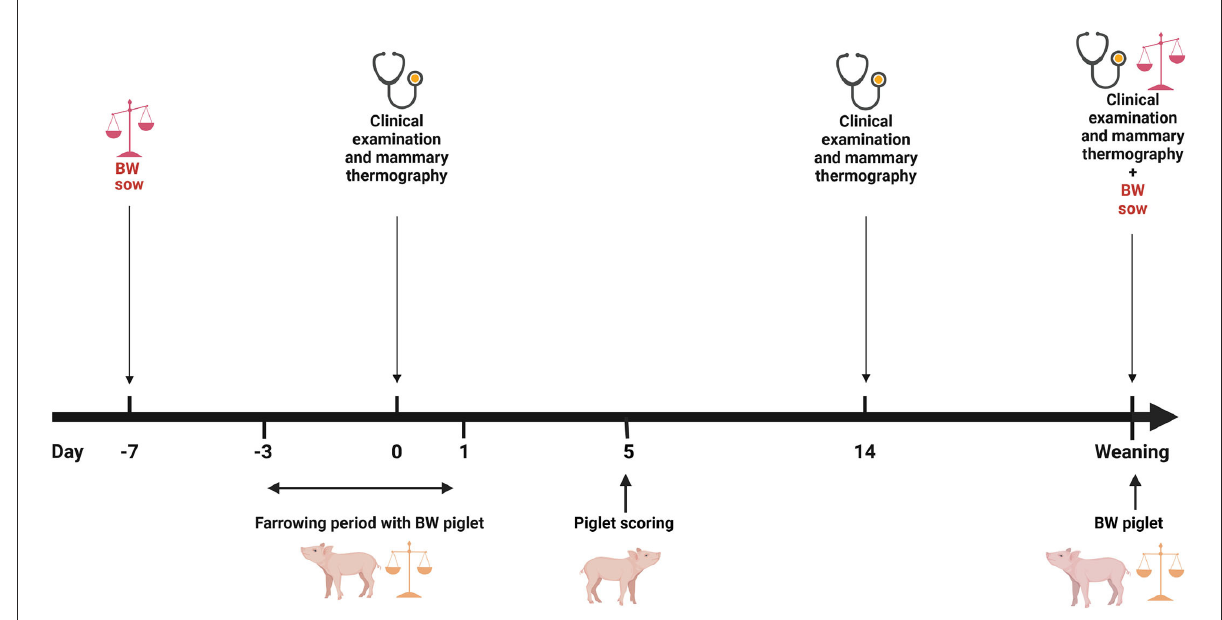
FIGURE1 Overview of the data collection. BW, bodyweight; (Figure was created with BioRender.com). Adapted from Rosengart et al. (18).